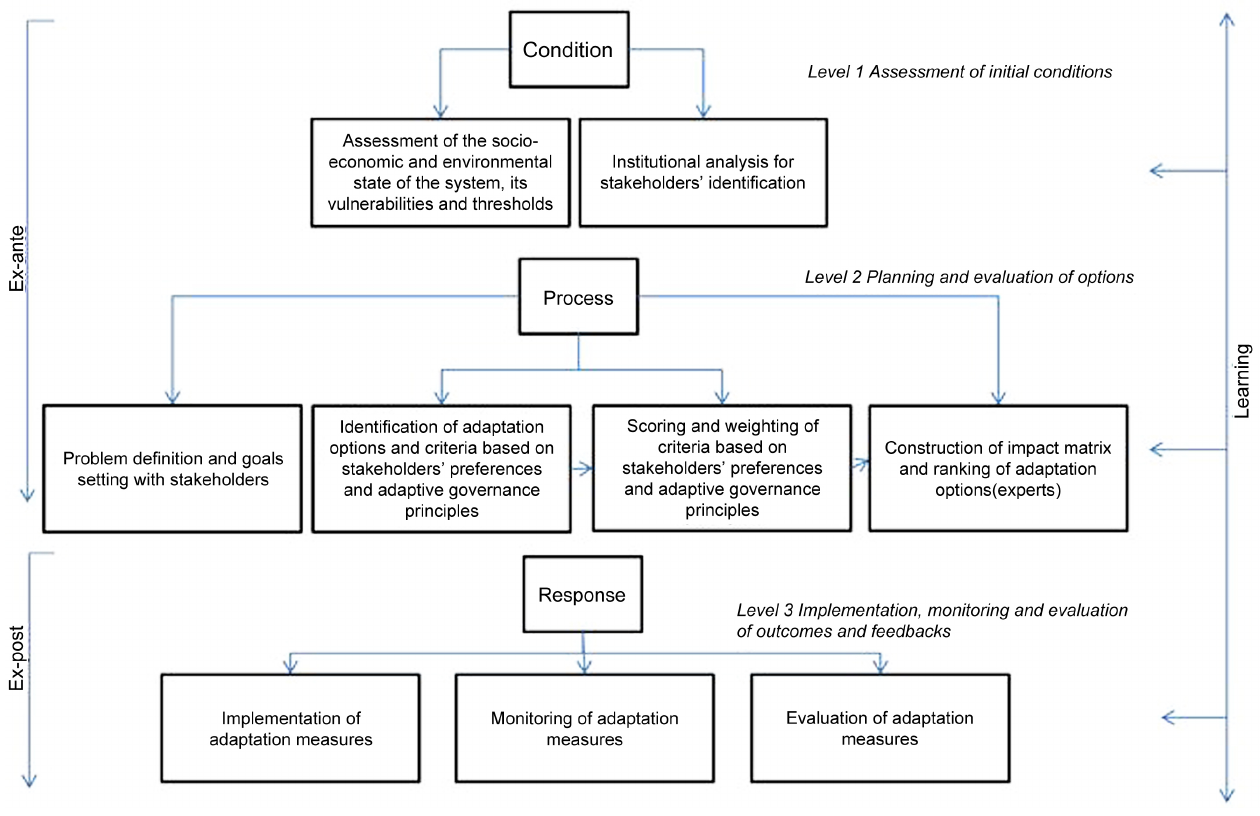
Fig. 1 . An adaptive participatory multicriteria framework for climate adaptation decision